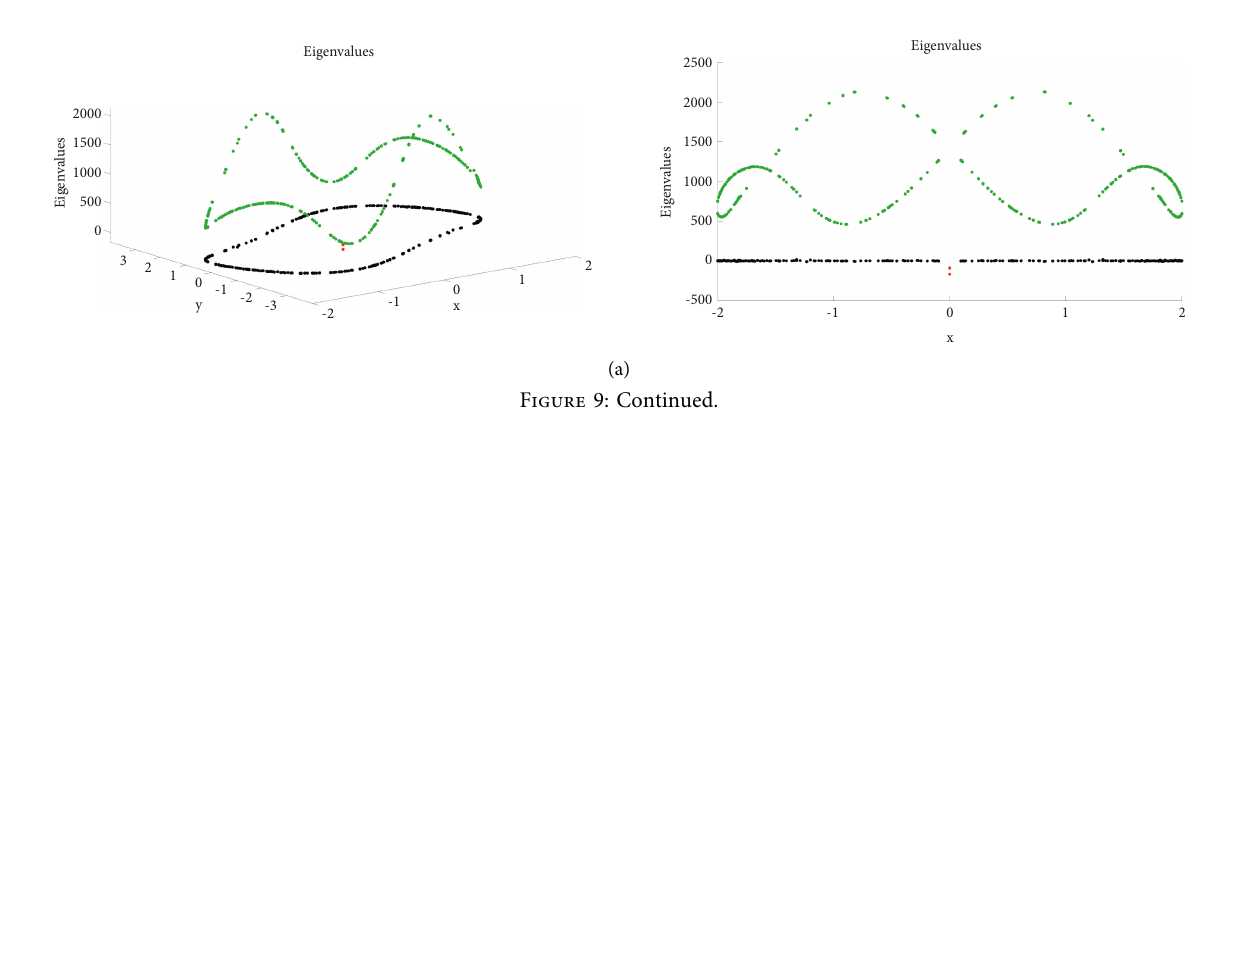
Figure 8: System (20). (a) Complete Lyapunov function v . (b) Its orbital derivative v ′ . (c) Norm of its gradient ‖ ∇ v ‖ . (d) Underestimation of the chain recurrent set C v, 0 . 6